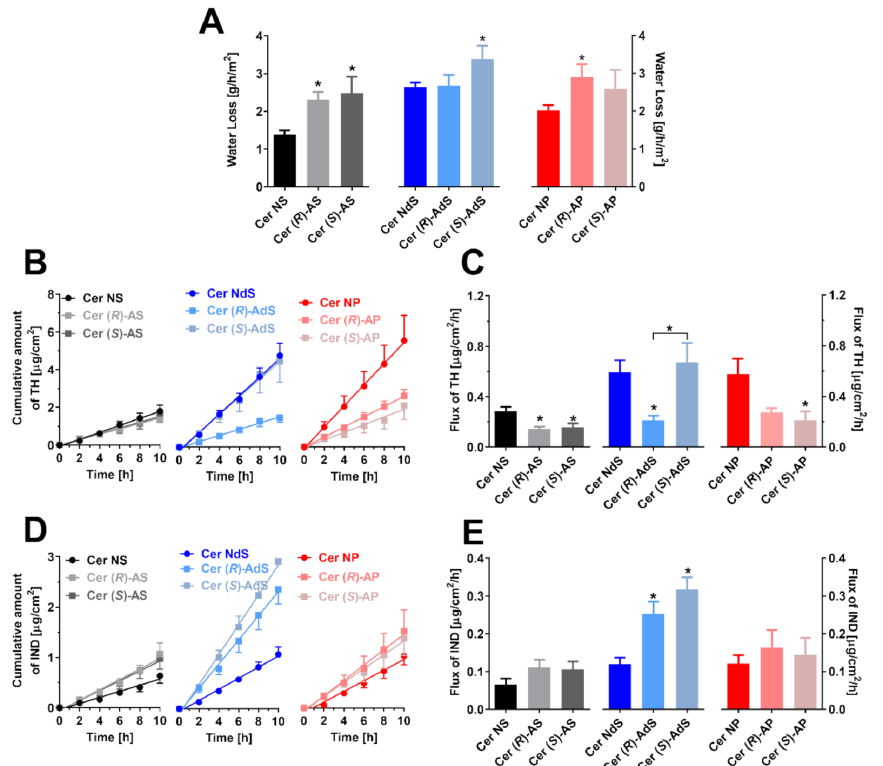
Figure 5. The permeabilities of the lipid films containing the studied Cers, FFAs, Chol, and CholS: water loss (Panel A ), TH permeation profiles ( B ) and TH flux values ( C ), IND permeation profiles ( D ), and IND flux values ( E ). Means ± SEM, n > 6. The asterisks indicate significant differences against respective non-hydroxylated Cers at p <